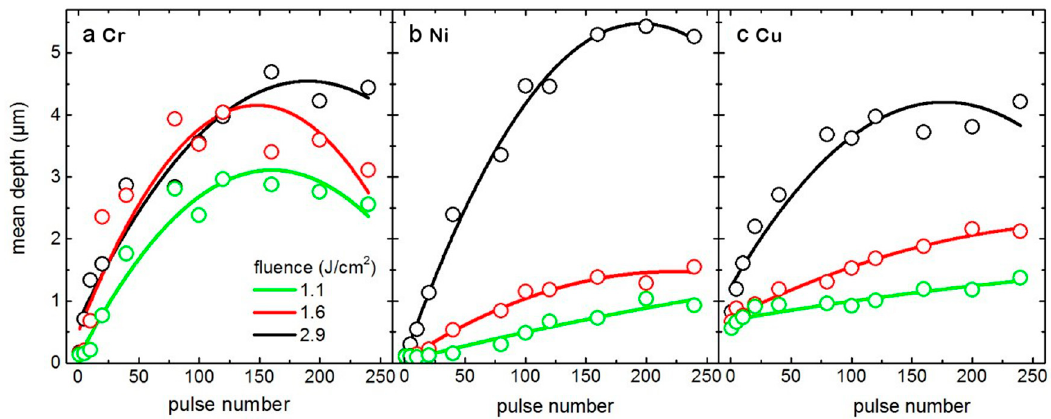
Figure 5. Dependence of the structure mean depth (open symbols) as a function of pulse number and with the fluence as a parameter on ( a ) Cr, ( b ) Ni, and ( c ) Cu. The lines are quadratic fits as a guide to the